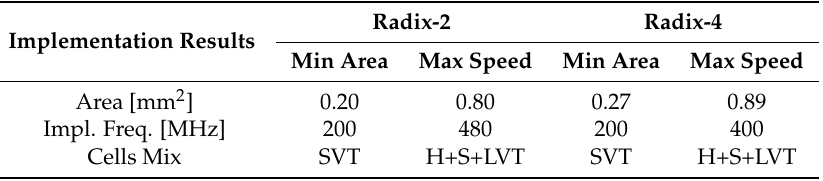
radix-2 and radix-4